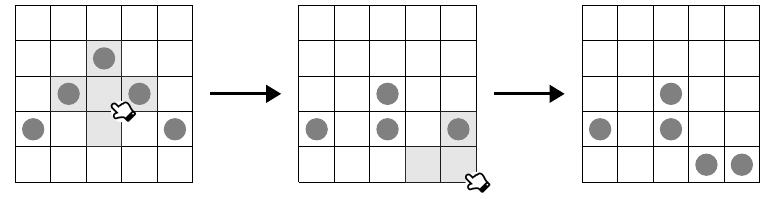
Figure 2. Example moves of a 5 × 5 Lights Out game.